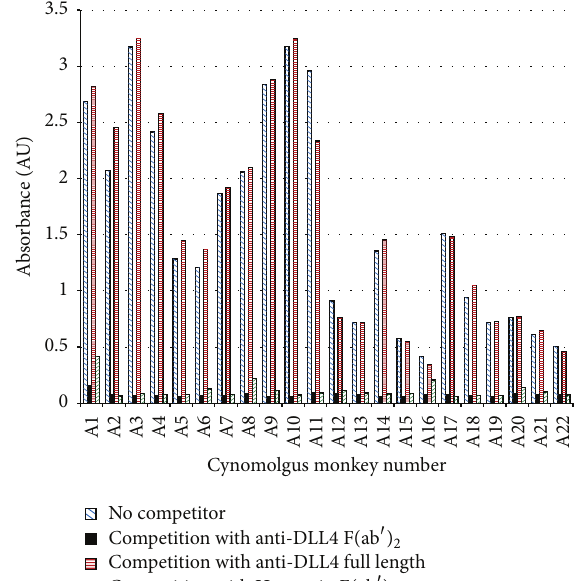
Figure 2: Preexisting ATAs are directed primarily at the F(ab 󸀠 ) 2 hinge,asshownbythereactivityreductionbycompetitionwithanti- DLL4 F(ab 󸀠 ) 2 , Herceptin F(ab 󸀠 ) 2 , or anti-DLL4 full length antibody in the bridging ELISA format. In the bridging ATA assay using 50 𝜇 g/mL competitor (in-well concentration) and a 1/20 sample dilution, full length antibody causes very little signal reduction; however the F(ab 󸀠 ) 2 form of the same antibody reduces the signal almost to background. An F(ab 󸀠 ) 2 form of Herceptin, which has the sameframeworkasanti-DLL4butwithadifferentCDR,alsoreduces the signal, indicating that the signal is due to anti-hinge antibodies.